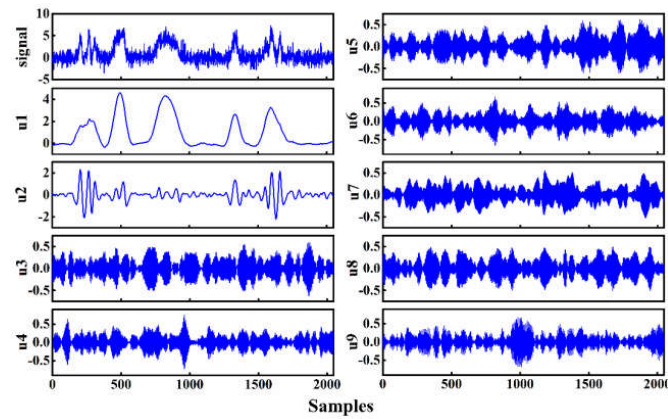
Figure 5. Bhattacharyya distance between modes and the Bumps signal. BLIMF is band-limited intrinsic mode function.